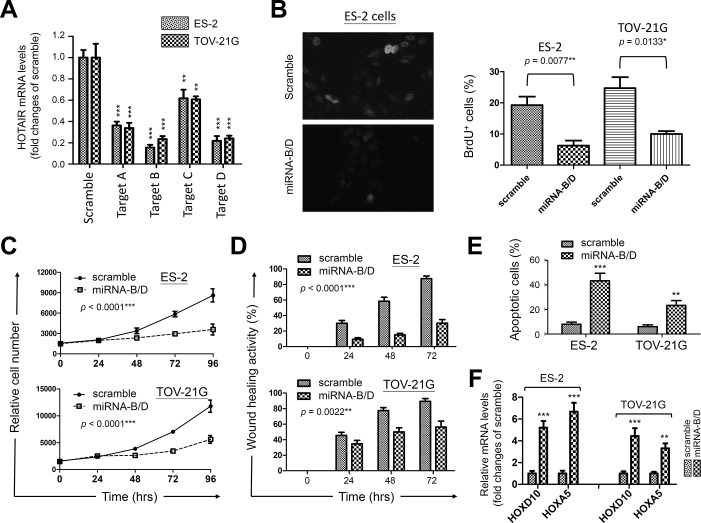
Functional impacts of HOTAIR knockdown on survival activity of ovarian clear cancer cells.(A) Specific miRNAs (set A to D) against HOTAIR were prepared and introduced into ovarian clear cancer cells, ES-2 and TOV-21G. Gene knockdown efficiency of each miRNA construct was verified by QPCR using scramble miRNA as the control. Data were averages of triplicates and presented as means ± S.D. (B) BrdU uptake assay was performed in cells transfected with scramble control or the mixture of anti-HOTAIR miRNA-B and miRNA-D (miRNA-B/D) (left). Positive cells were counted and averaged as means ± S.D. from 200 nuclei (right). (C) MTT assay and (D) wound healing assay were performed to investigate the impacts of HOTAIR knockdown by miRNA-B/D on cell growth and migration, respectively. (E) Apoptotic cells were detected by annexin V staining in cells 72 hrs after transfection. Data in (C) and (D) were averages of five replicates and presented as means ± S.D. (F) The expression levels of HOXD10 and HOXA5 were analyzed by QPCR in transfected cells 24 hrs after HOTAIR knockdown. Cells treated with scramble were utilized as the controls. Data were averages of triplicates and presented as means ± S.D. For (A), (B), (E) and (F), data from miRNA-B/D treated cells were compared to the ones from scramble control by using t-test. For (C) and (D) time course studies, two-way ANOVA was utilized to analyze statistical significance. The p values were presented as *: p value < 0.05, **: p value < 0.01, and ***: p value < 0.001.